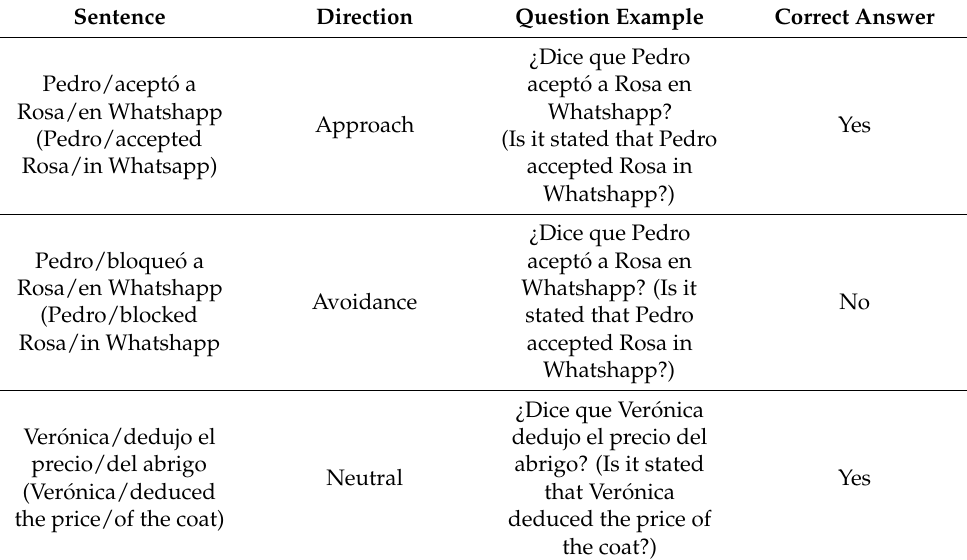
Table 1. Examples of approach, avoidance and neutral sentences with